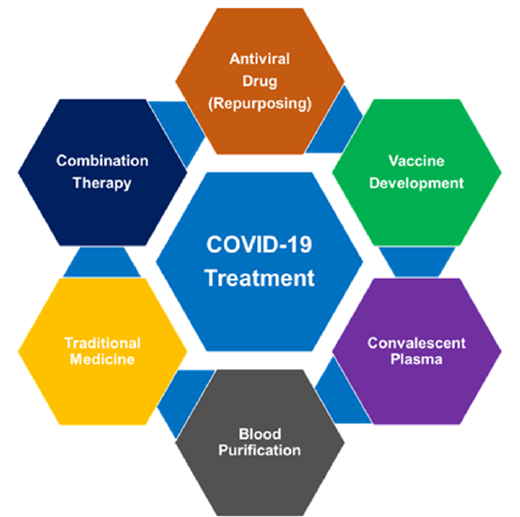
Figure 3. Possible treatment modalities against COVID-19.